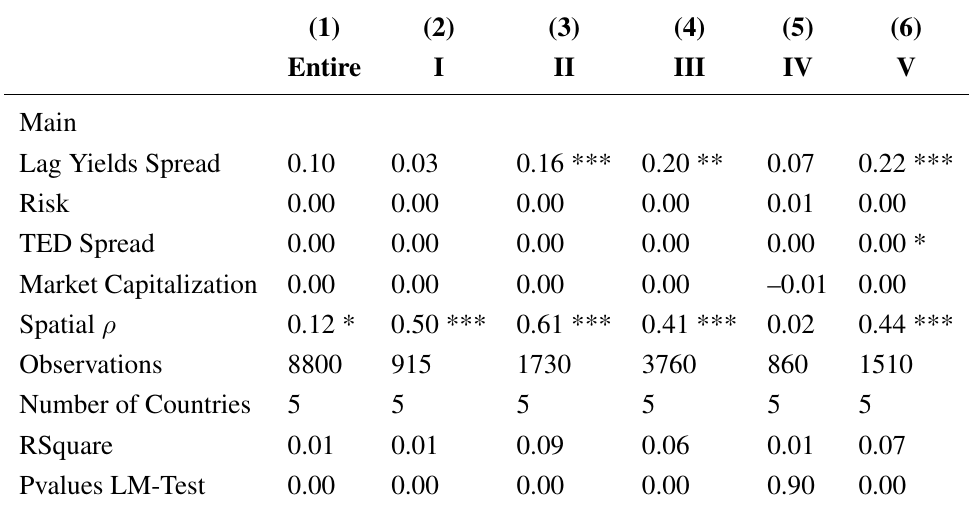
Table 2. Empirical results for highly exposed countries to the sovereign debt crisis.